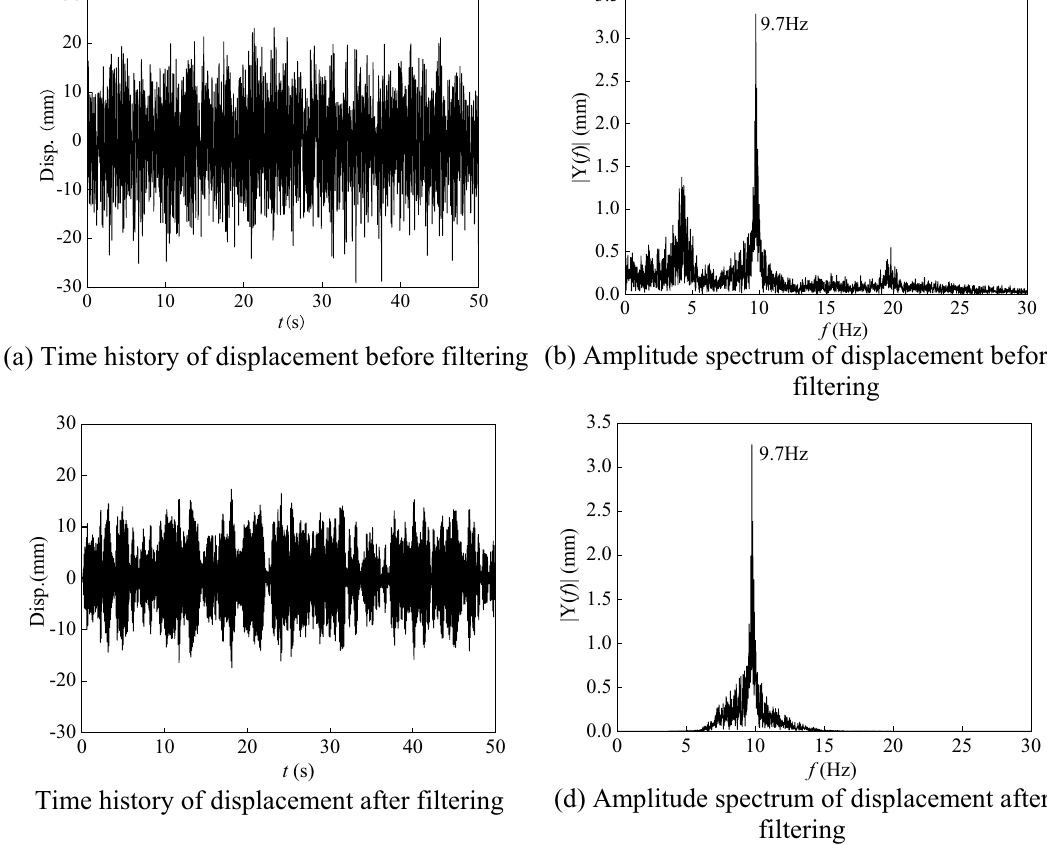
Figure 4. Time histories of displacement and amplitude spectrum before and after